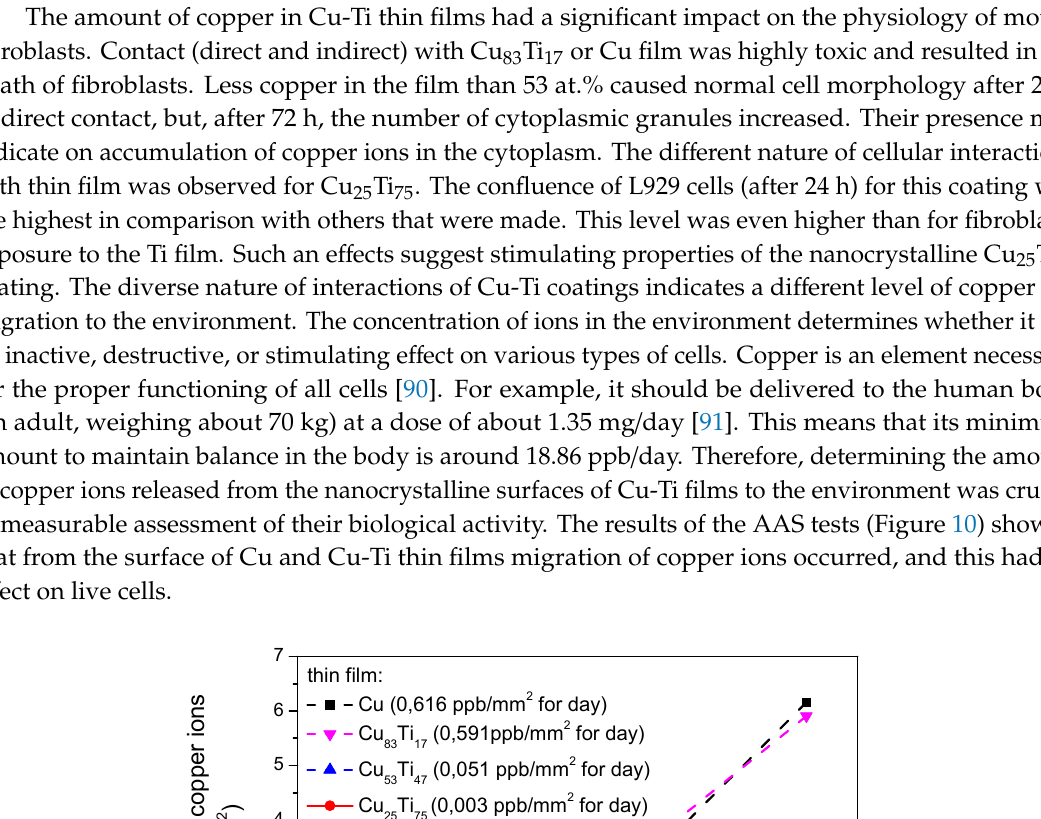
Figure 9. The influence of material composition on the biological properties of nanocrystalline thin films based on copper and titanium.